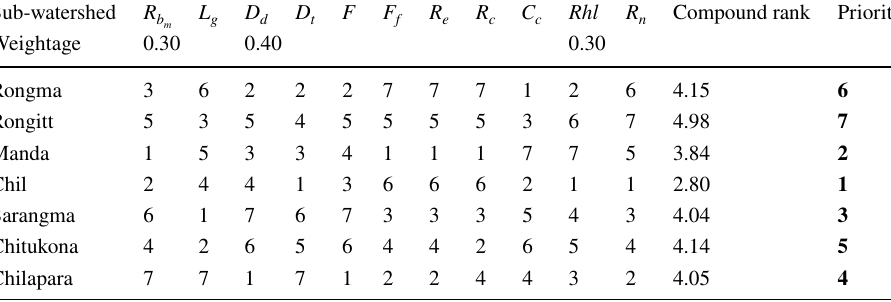
Table 3 Sub-watershed ranks based on the morphometric parameters w.r.t. soil erosion